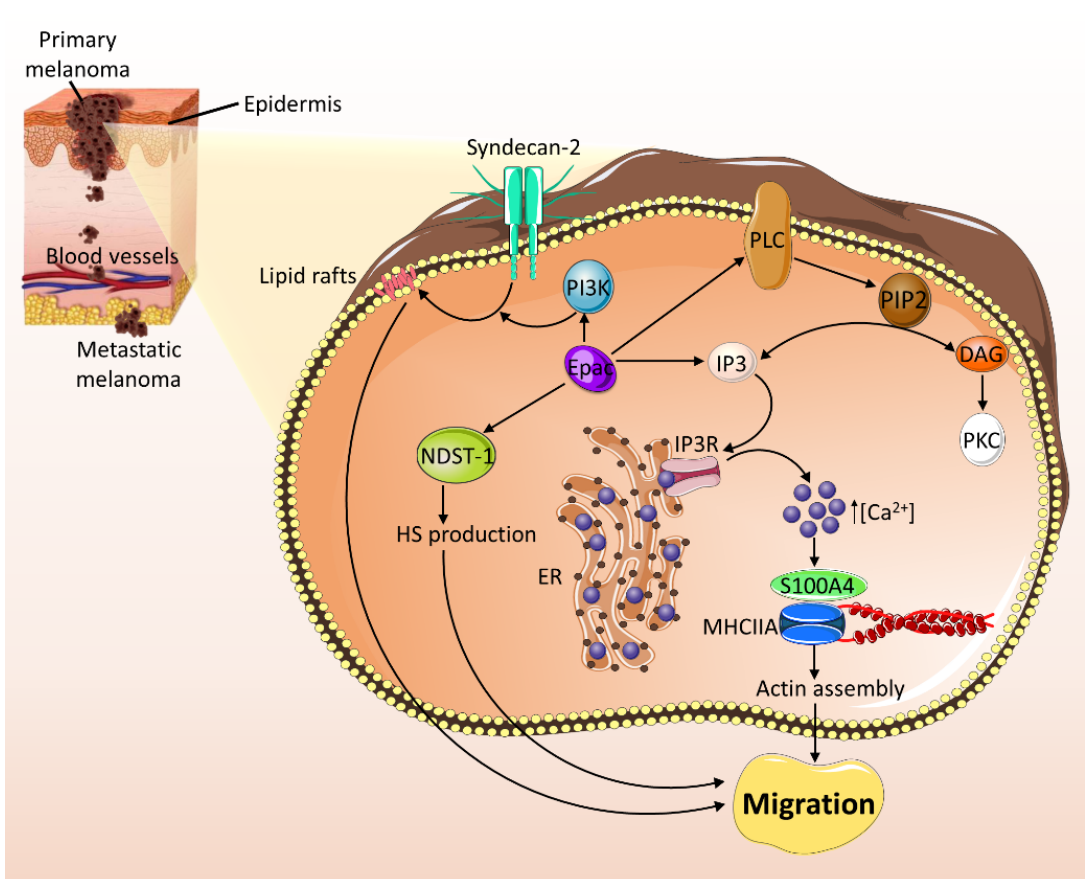
Figure 5. Epac promotes cell migration and metastasis in melanoma. Epac activates PI3K pathway, which promotes tubulin polymerization mediating the translocation of syndecan-2 into lipid rafts. Furthermore, Epac upregulates the expression of NDST-1, resulting in an increase in HS production. Both the translocation of syndecan-2 and the increase in HS production induce cell migration and metastasis. Epac also promotes melanoma cell migration and metastasis via a Ca 2+ -dependent mechanism. Epac activates phospholipase C (PLC), which catalyzes the breakdown of PIP2 into IP3 and DAG, activating the calcium signaling pathway. Epac can also activate inositol triphosphate (IP3). Activated IP3 bind to its receptor, IP3R1, on the membrane of ER, leading to the release of Ca 2+ . The increase in intracellular levels of Ca 2+ enhances the interaction between S100A4 and MHCIIA, consequently promoting actin assembly and cell migration/metastasis. DAG: diacylglycerol; ER: endoplasmic reticulum; HS: heparan sulfate; IP3: inositol triphosphate; IP3R1: inositol 1,4,5- sulfate; IP3: inositol triphosphate; IP3R1: inositol 1,4,5-triphosphate receptor isoform 1; MHCIIA: triphosphate receptor isoform 1; MHCIIA: myosin heavy chain IIA; NDST-1: N-deacetylase/N- myosin heavy chain IIA; NDST-1: N-deacetylase / N-sulfotransferase-1; PIP2: phosphatidylinositol sulfotransferase-1; PIP2: phosphatidylinositol 4,5-bisphosphate; PI3K: phosphoinositide 3-kinase; 4,5-bisphosphate; PI3K: phosphoinositide 3-kinase; PKC: protein kinase PKC: protein kinase C.